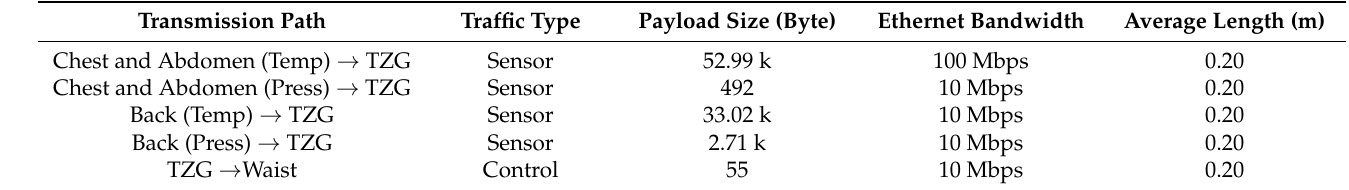
Table 8. Data transmission link parameters of the ZIRA Torso Zone.